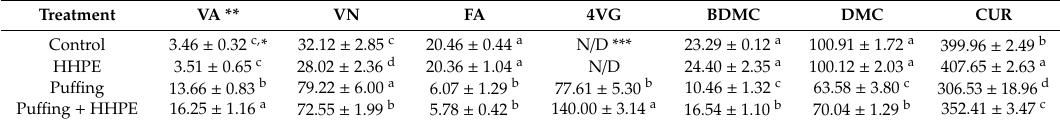
Table 4. E ff ect of the combination of pu ffi ng and HHPE on bioactive compounds (g / g dried turmeric) of